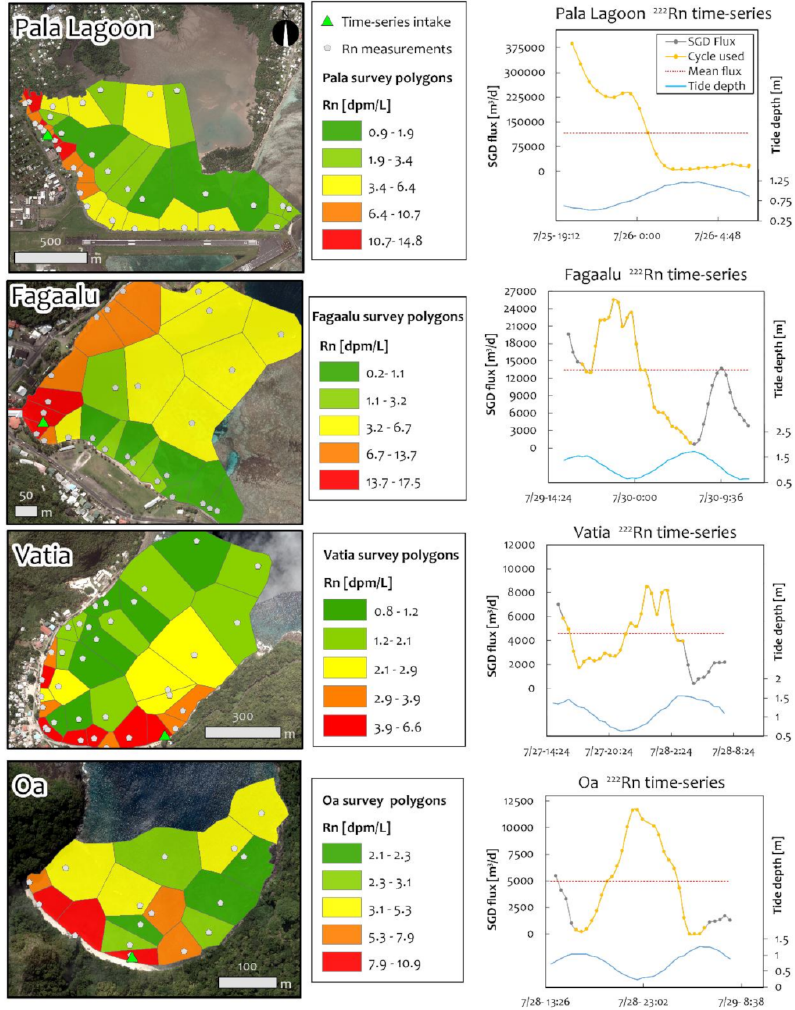
Figure 6. Radon survey and time series results. Left map-panels show 222 Rn survey measurement locations (grey dots), time series intake locations (green triangles) and geometries of Thiessen Polygons color coded by dissolved 222 Rn concentration at each measurement point for the four study locations. Note different color scales for each map. Right plot-panels show processed total SGD fluxes calculated from the time series measurements after integration of spatial data from 222 Rn surveys. To standardize daily average fluxes, only measurements taken within a single tidal cycle (12.2 h) were used (gold portion of grey lines). Note that mean-daily SGD fluxes (red dotted lines) represent total SGD (fresh +